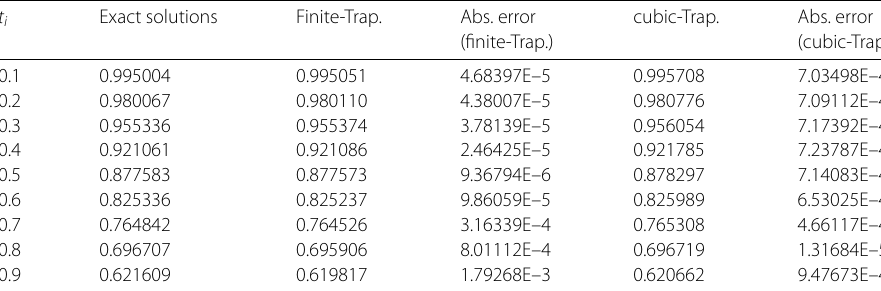
cubic-Trap. Abs. error (finite-Trap.) (cubic-Trap.)